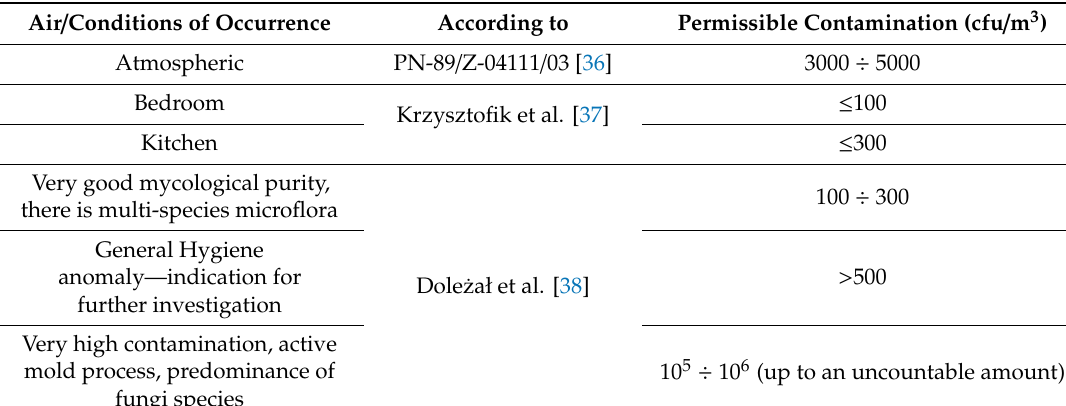
Table 4. Scale for assessing microbiological contamination of air.